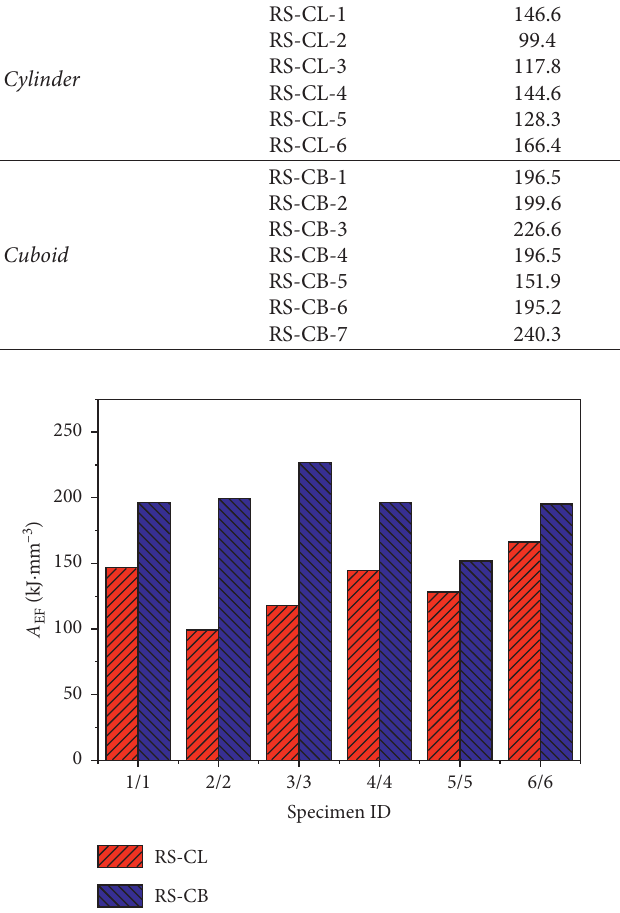
Figure 8: Comparative results of cylindrical and cuboid specimens with A EF .